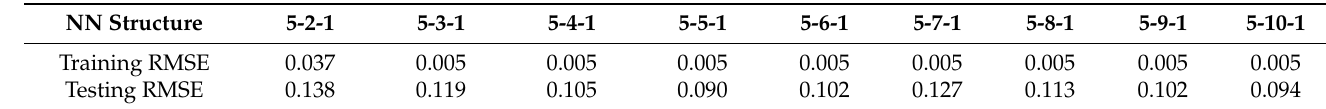
Table 16. Candidate neural networks.